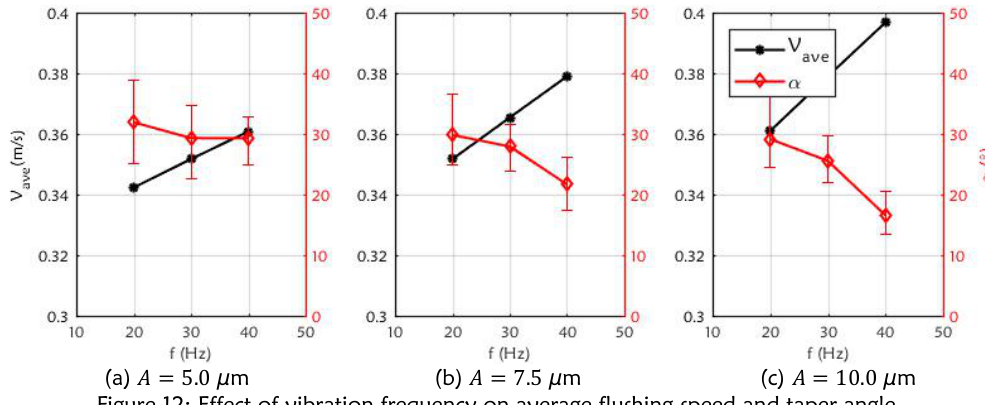
Figure 12: Effect of vibration frequency on average flushing speed and taper angle